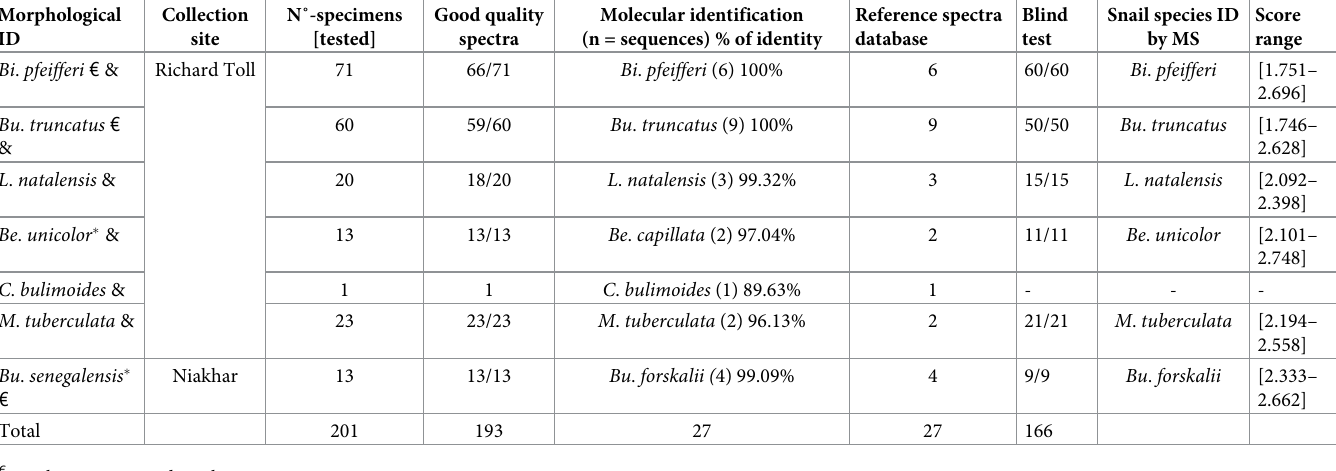
Table 2. Laboratory-reared and field species selected to create a MALDI-TOF MS reference database, identified molecularly using COI . Morphological Collection ID